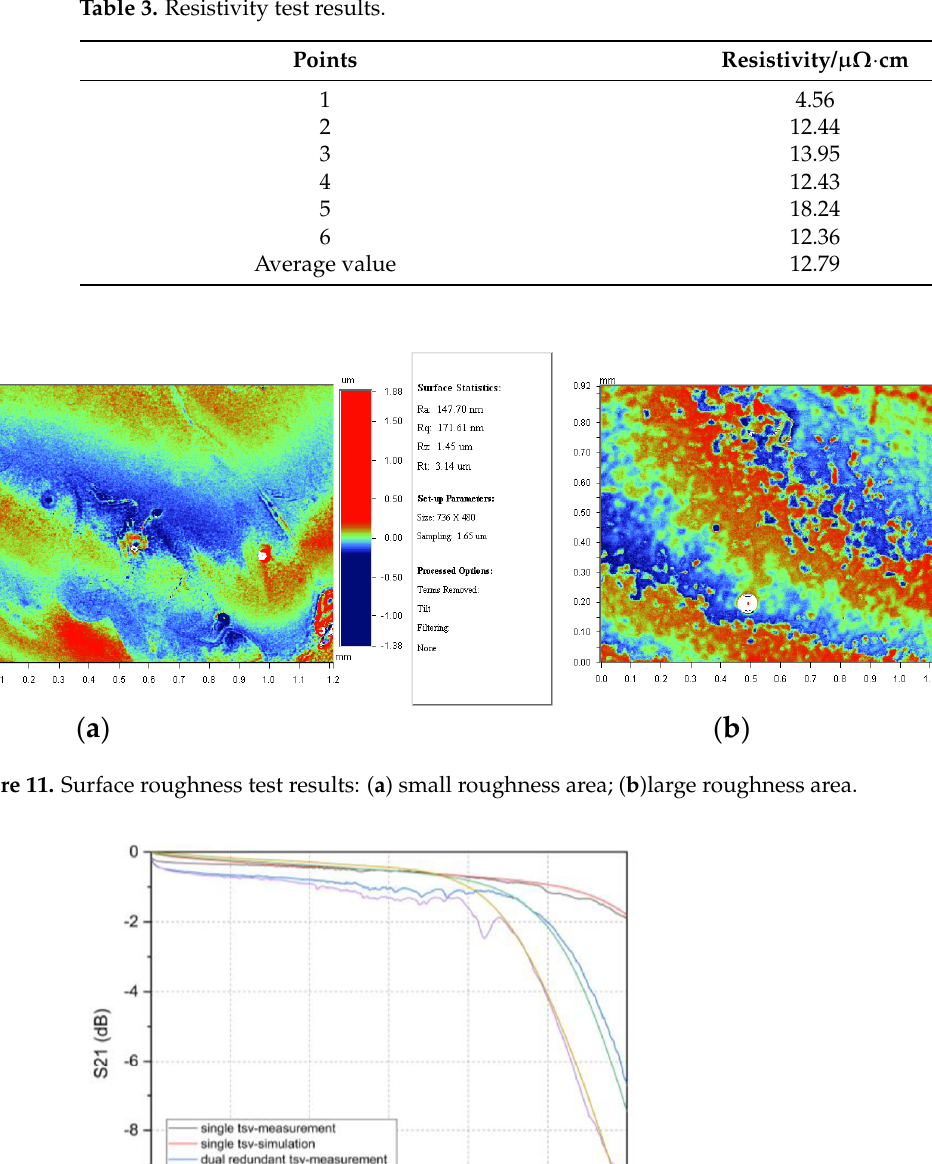
Table 3. Resistivity test results.